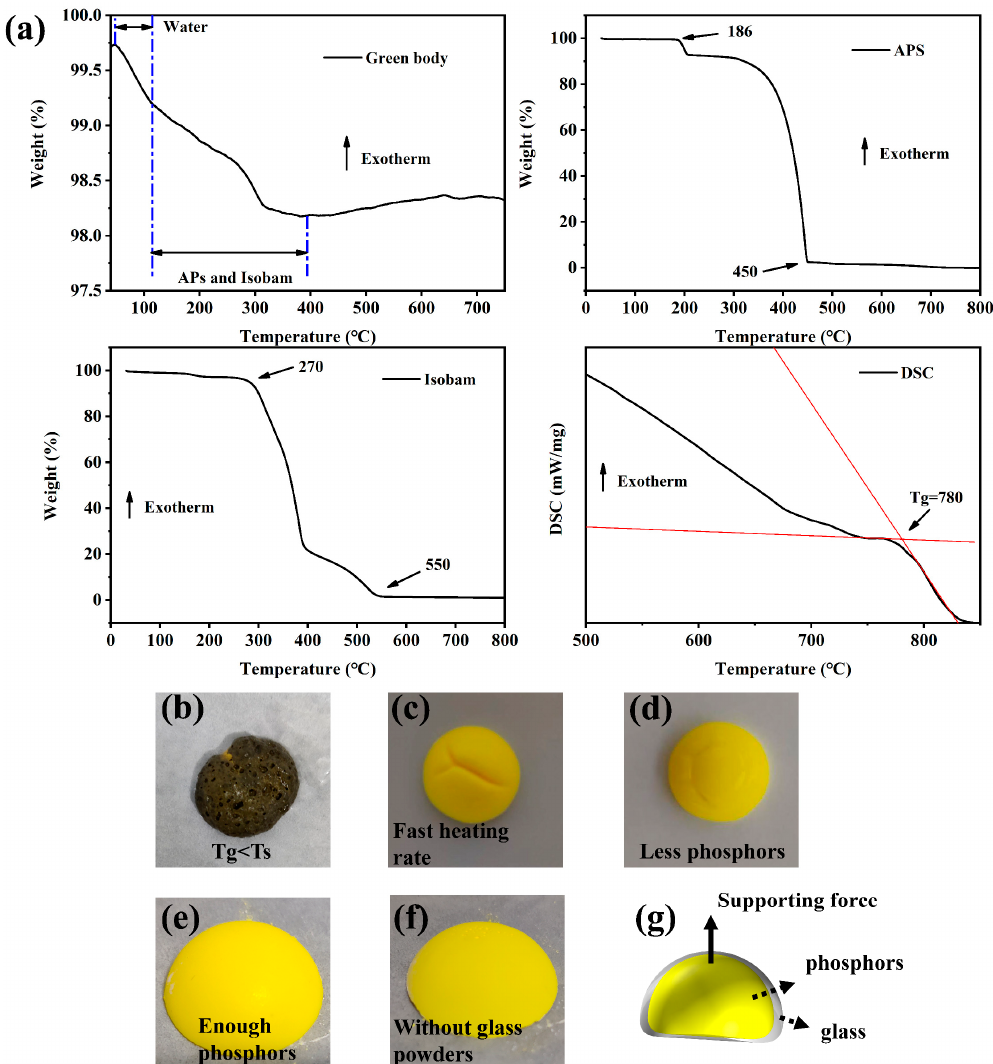
Figure 2. ( a ) Weight loss curves of green bodies, APS and Isobam and DSC curve of glass powders; ( b ) photos of PiGs with low Tg and ( c ) in fast sintering rate; ( d – f ) photos of PiGs with different phosphors content; ( g ) schematic diagram of phosphors supporting glass.